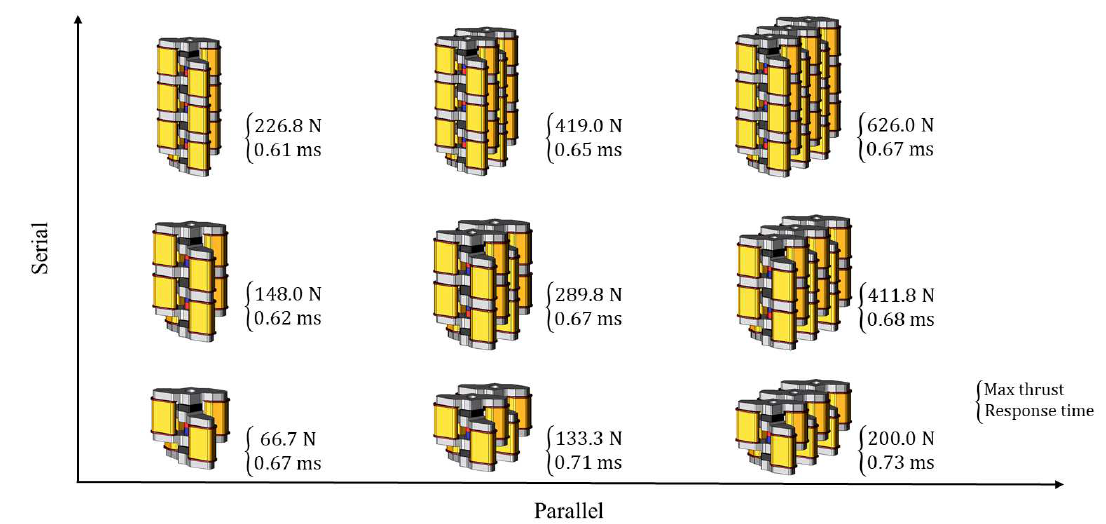
Figure 19. Application of the basic